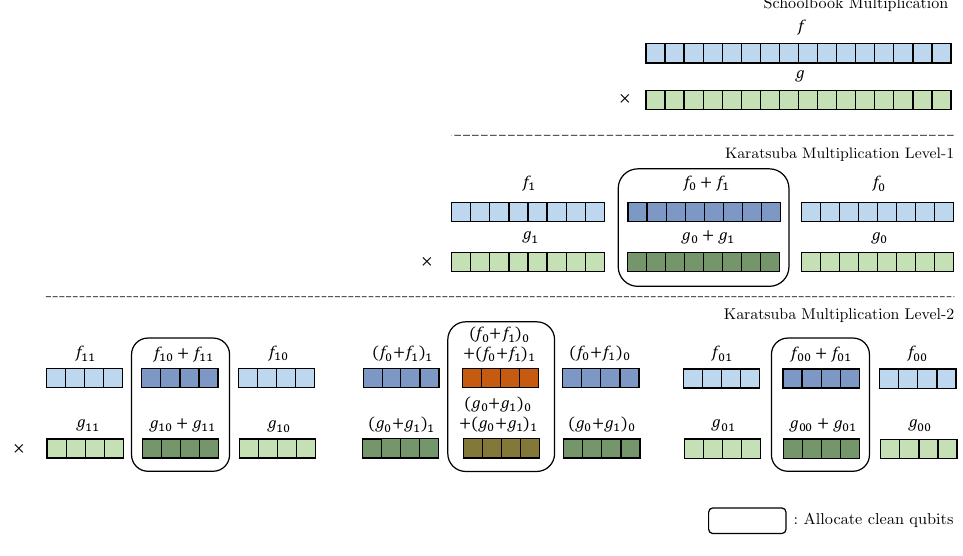
Figure 3. Overview of the proposed